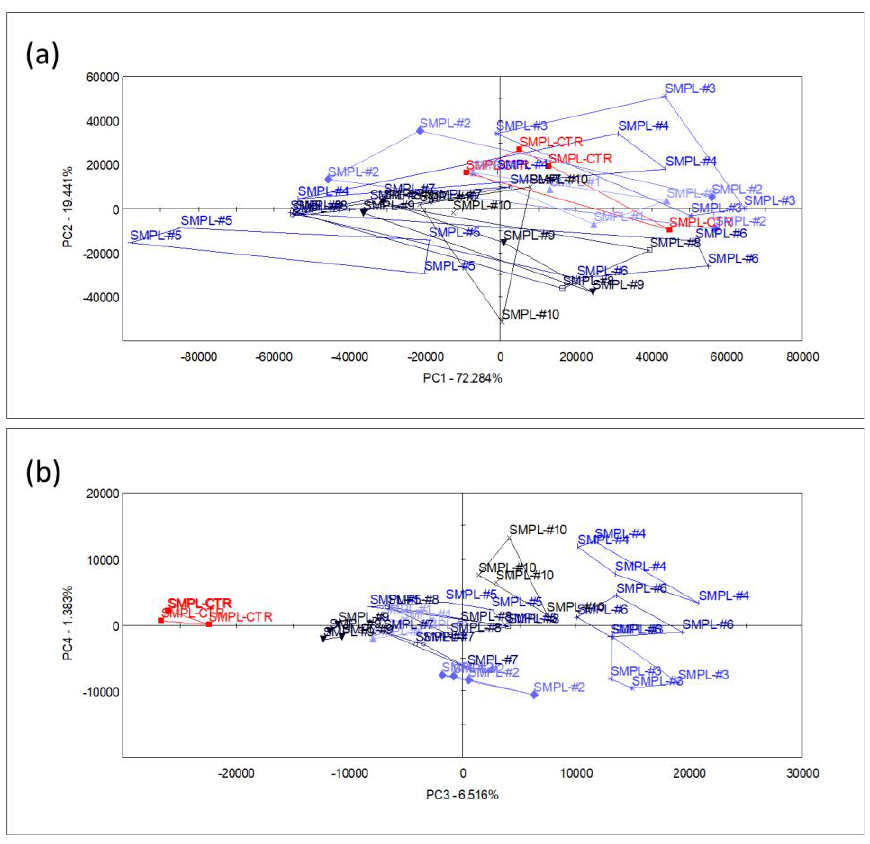
Figure 3. Score plots of PCA performed with data from all sensors, showing the planes of the 1st and 2nd principal components ( a ) and the 3rd and 4th principal components ( b ) (n = 4 replicates/sample, SMPL-CTR: milkshake with no supplementation (control); SMPL#1 to SMPL#10: milkshake samples with increasing levels of SP17-100 supplementation (0.2% – 2%).